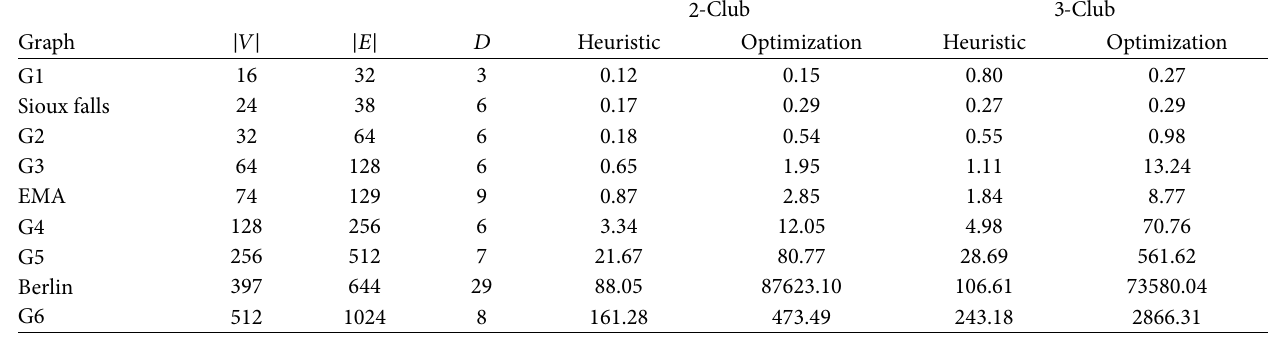
Table 1: Computational times under heuristic and optimization approach for 푘 = 2, 3 .